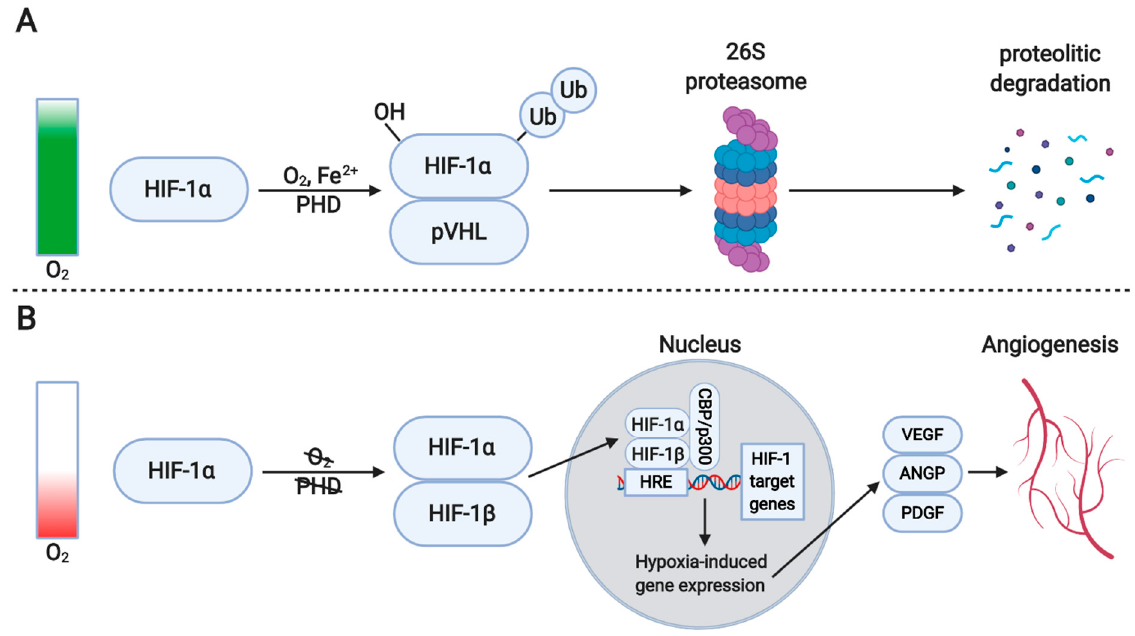
Figure 2. The regulation of hypoxia-inducible factor 1 α (HIF-1 α ) activity. ( A ) Under normoxic conditions, prolyl hydroxylase (PHD), in the presence of Fe 2+ and an oxygen molecule, hydroxylates proline residues in the oxygen-dependent degradation domain of HIF-1 α . This allows recognition and interaction with the von Hippel-Lindau (pVHL) E3 ubiquitin ligase leading to HIF-1 α ubiquitination and subsequent degradation by 26S-proteasome. ( B ) Under hypoxic conditions, the hydroxylation and degradation of HIF-1 α are blocked. Thus, HIF-1 α can dimerize with HIF-1 β , enter the nucleus and bind hypoxia response elements (HREs) within the promoters of target genes. Together with the co-activator proteins p300 and CBP, the HIF complex transcriptionally regulates the expression of its target genes such as VEGF, PDGF and ANGP, finally regulating many processes including angiogenesis. Created with BioRender.